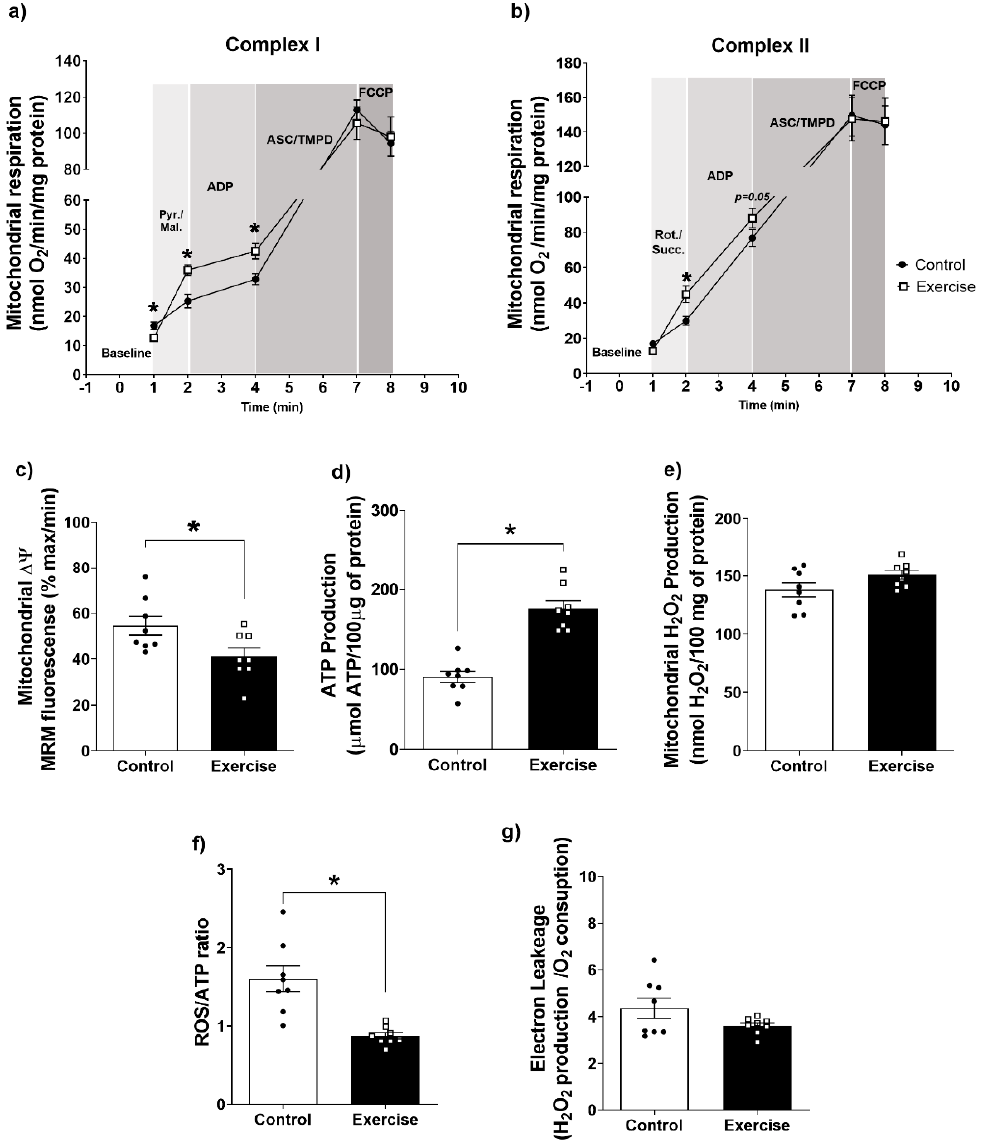
Figure 2. Effects of aerobic exercise on mitochondrial function in retroperitoneal WAT. Analysis of